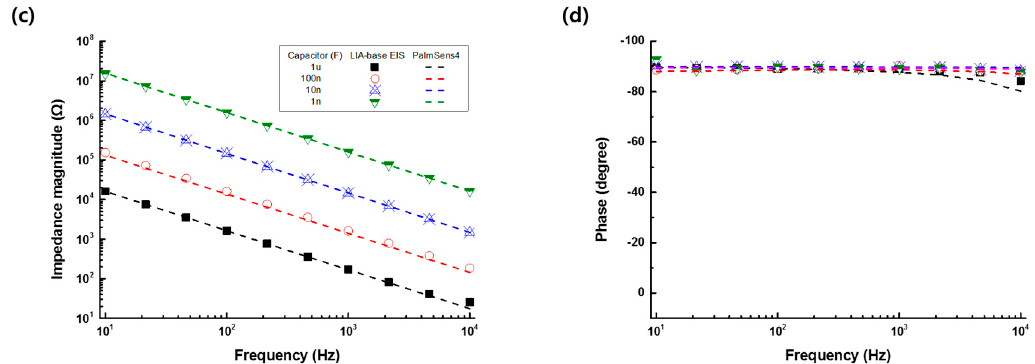
Figure 2. ( a ) Electrical impedance magnitude and ( b ) phase of the resistors (100 Ω to 1 M Ω ) or the ( c ) impedance magnitude and ( d ) phase of capacitors (1 nF to 1 µ F) measured by the developed impedance measurement system (symbols) and commercialized product (PalmSens4, lines) in the frequency range of 10 Hz to 10 kHz.